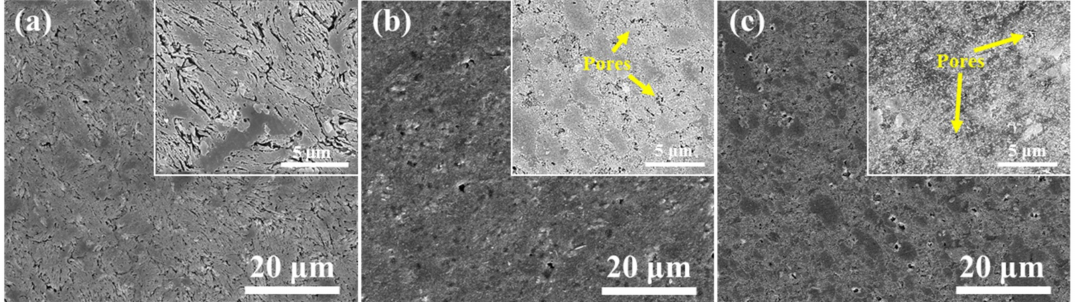
Figure 7. SEM micrographs of sintered samples with di ff erent ball milling time ( a ) S10, ( b ) S20 and ( c )